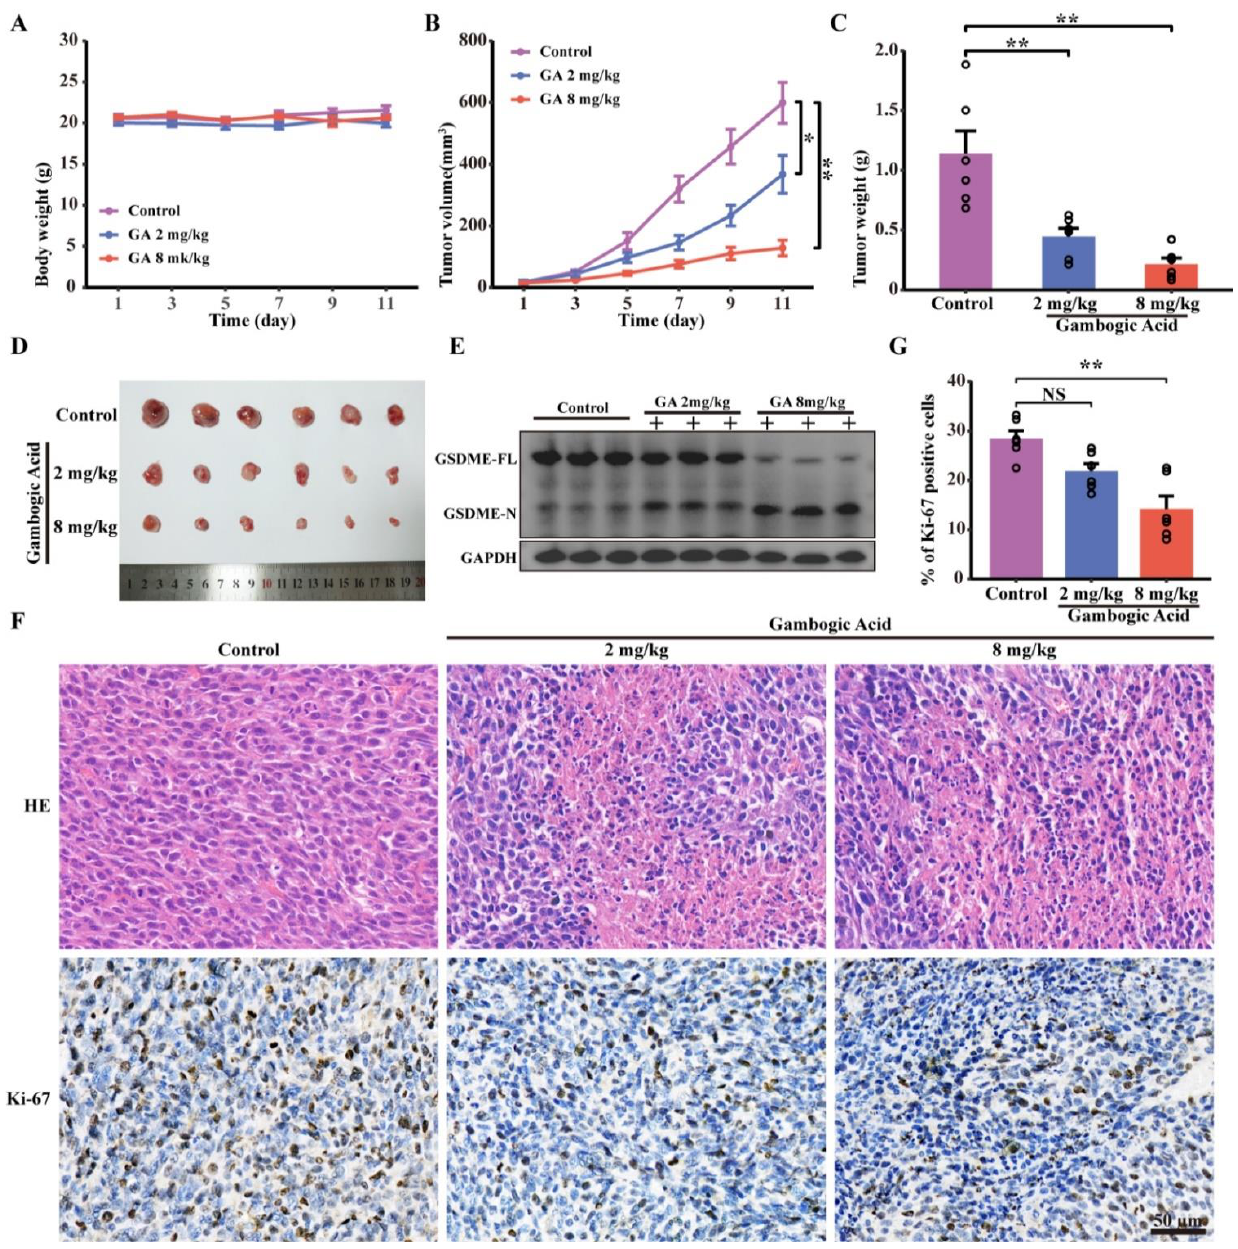
Figure 7. GA inhibited the tumor growth and triggered pyroptosis of CRC cells in vivo. CT26 cells were inoculated into BALB/c mice to establish the murine xenograft model. ( A ) Change curves of mice weight after GA treatments ( n = 6). ( B ) Tumor volume, ( C ) tumor weight, ( D ) photographs of isolated tumor after GA treatment. ( E ) Western blotting analyses of GSDME-FL and GSDME-N expression in treated tumor tissues. The whole western blots were shown in Figure S6. ( F ) H&E staining and Ki-67 immunohistochemistry analysis of tumor tissues after GA treatments. ( G ) Quanti- tation of Ki-67 staining from immunohistochemical analysis. NS, not significant, * p < 0.05 vs. control, ** p < 0.01 vs.